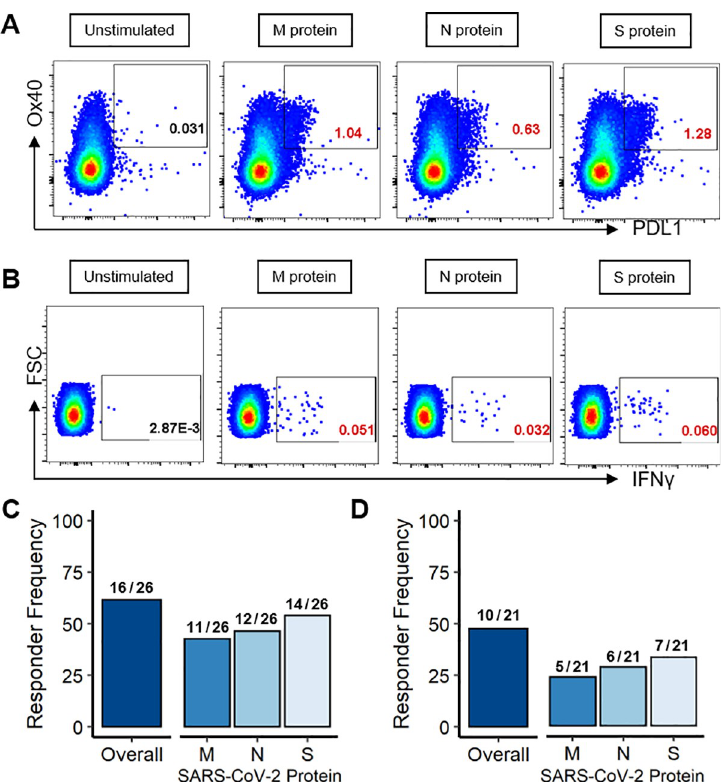
Fig 1. SARS-CoV-2-specific CD4 T cells target the M, N, and S proteins in individuals recovered from COVID-19 at their first convalescent visit. Representative examples of CD4 T-cell responses in CID8 to the M, N, and S protein peptide pools as detected by upregulation of activation-induced markers, Ox40 and PDL1 (A) and by IFN γ in intracellular cytokine staining (B) . Responder frequency of CD4 T-cell responses to any SARS-CoV-2 protein and to the M, N, and S proteins individually by AIM (C, N = 26 ) and ICS (D, N = 21 ) . Positive SARS-CoV-2-specific responses are indicated by gate frequencies in red.